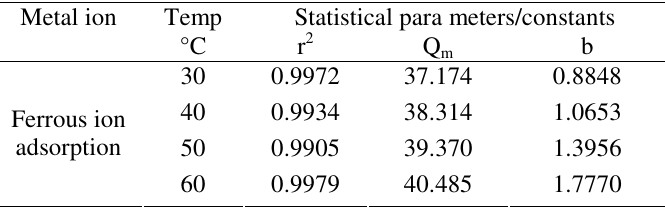
Table 3. Langmuir isotherm results